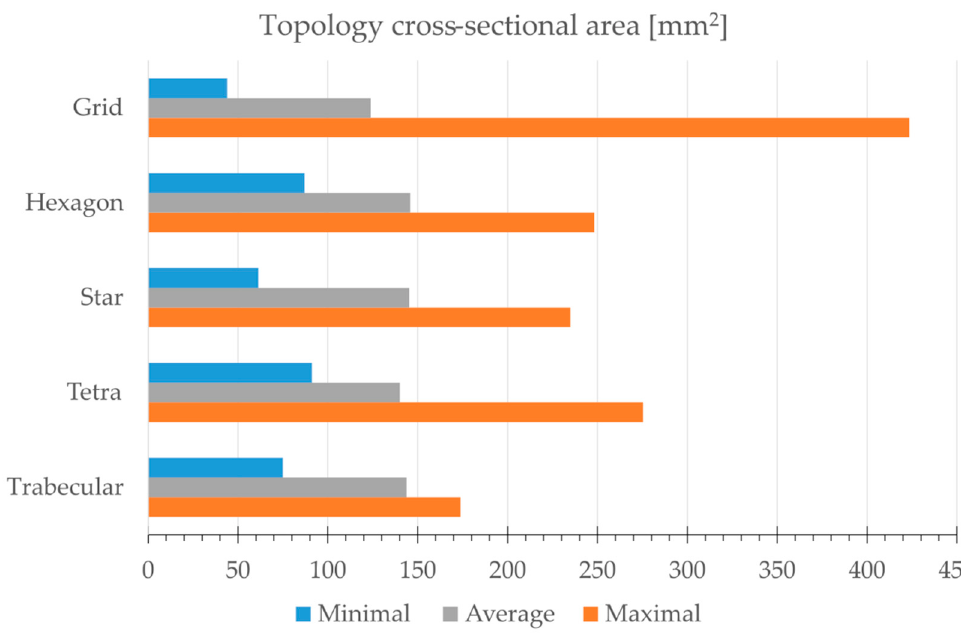
Figure 4. Graphical comparison of variation and mean cross-sectional area of all topologies.